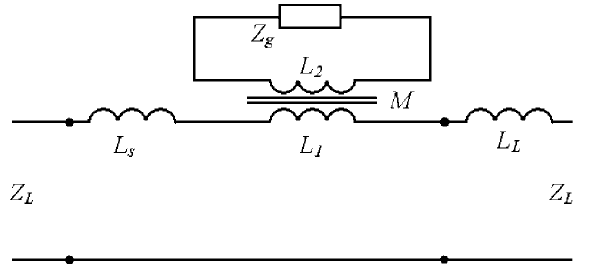
FIG. 1. The low frequency kicker model with the two con- tributions to the transverse coupling impedance in bench